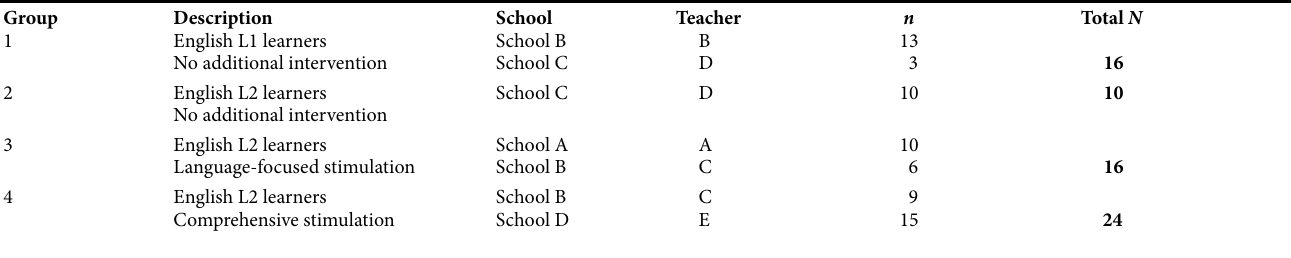
table ii. Allocation of participants to groups